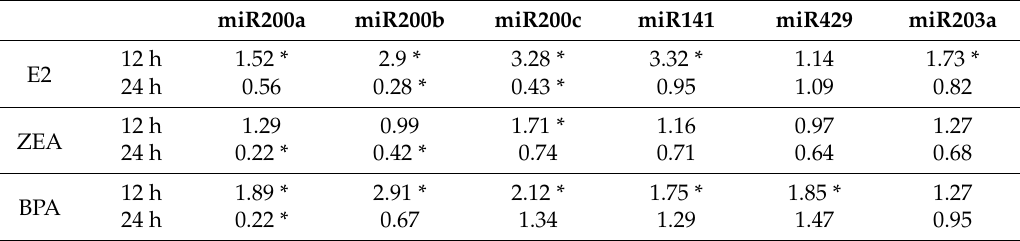
Table 2. Relative expression ratios of miR200s, miR34s and miR203a after estrogen treatments in the PEO1 cell line. MiRNA was isolated from the cells 12 and 24 h after E2, ZEA and BPA exposure. Relative expression ratio was calculated relative to the expression value of miRNAs in the non-treated control (1). Ratio > 1 indicates upregulation relative to the non-treated control. Ratio < 1 indicates downregulation relative to the non-treated control. Significance was determined between the ∆ CT values of treated and non-treated samples: * p < 0.05.